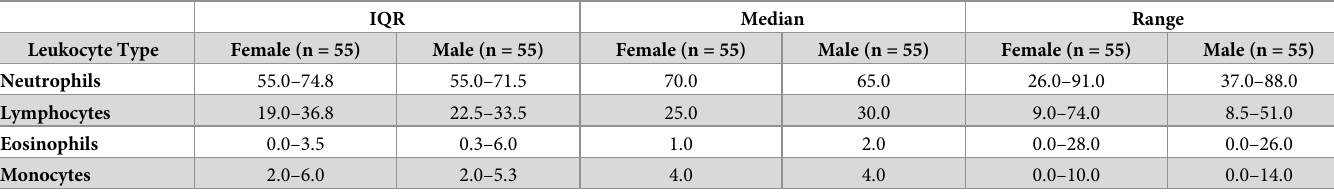
Table 1. Leukocyte profiles of P . alecto with no observed injuries.